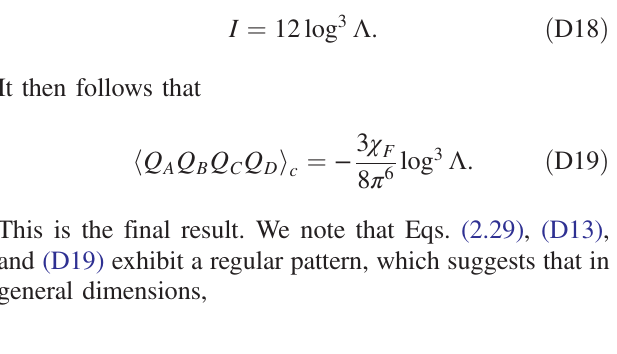
TABLE I. Summary of logarithmic divergence c log 3 Λ , con- tributed from the straight line configuration with ordering abcd (as permutation of ABCD ). For instance, c abc is the coefficient abcd of log 3 divergence contributed by orienting the abcd line along the triple contact ˆ m . The superscript of c labels a specific part abc of the one-parameter family in Fig. 14(b).